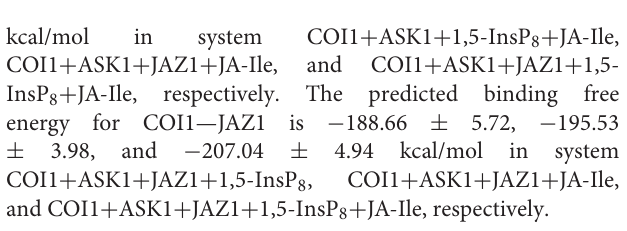
FIGURE 10 | Monitoring of the intermolecular hydrogen bonds between JA-Ile and COI1 during the MD simulation, (A) system 3 (COI1 + ASK1 + 1,5-InsP 8 + JA-Ile); (B) system 4 (COI1 + ASK1 + JAZ1 + JA-Ile); (C) system 6 (COI1 + ASK1 + JAZ1 + 1,5-InsP 8 + JA-Ile).